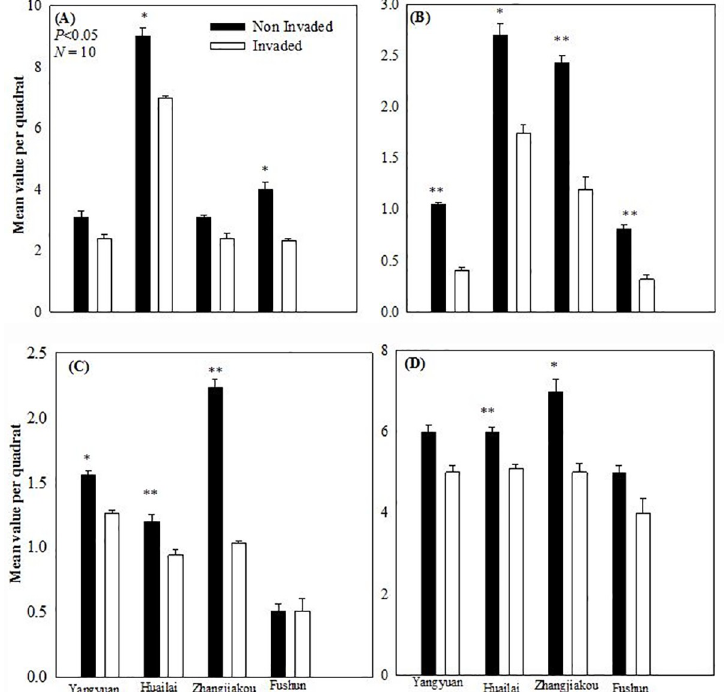
Fig 3. Difference in each ecological index between the invaded and non-invaded quadrats at Yangyuan, Huailai, Zhangjiakou and Fushun. (A), Abundance; (B), Shannon’s Diversity Index; (C), Margalef’s Richness Index; (D), Species Richness. Mean ± 1 SE ( N = 10). � , P < 0.05, �� , P < 0.01, NS, P > 0.05.